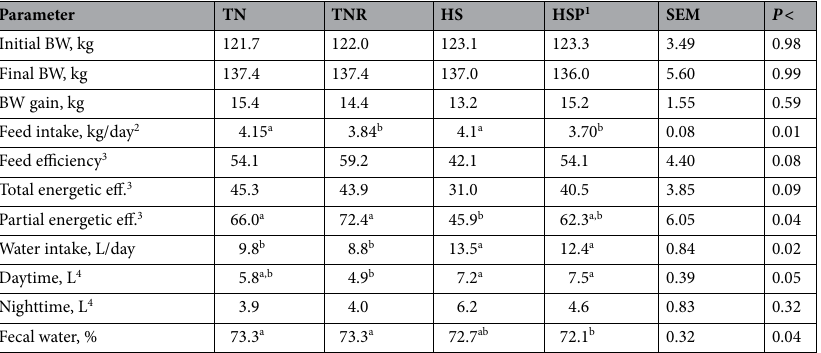
Table 1. The postbiotic restored partial energetic efficiency of Holstein bull calves exposed to heat stress (n = 8 per treatment). TN thermoneutral, TNR thermoneutral feed-restricted, HS heat stress, HSP heat stress- postbiotic, SEM standard error of the mean. a,b Values within the same row with different superscripts denote significance differences ( P < 0.05). 1 AO postbiotic fed at 3 g/calf/day and mixed with milk replacer. 2